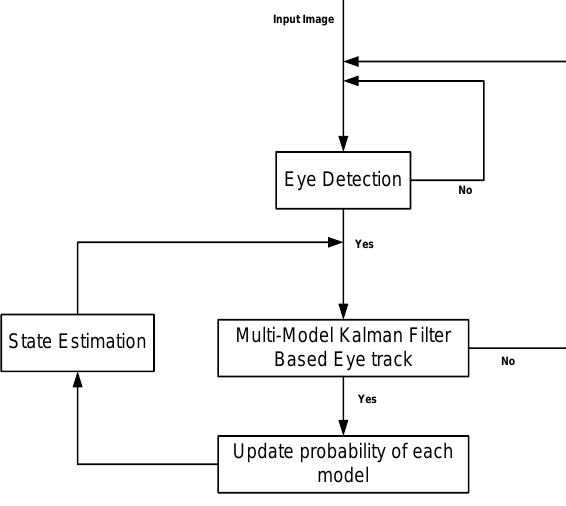
Figure 1. Block diagram of the proposed method of eye